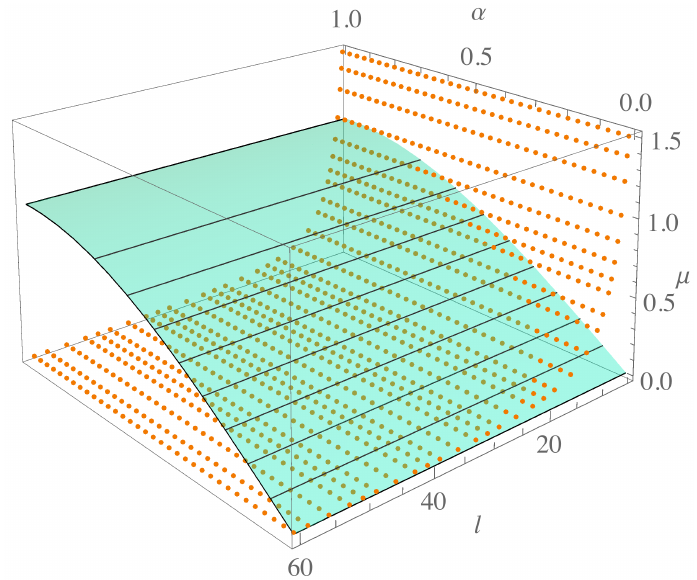
Figure 3. Intersection of the two surfaces µ c and µ α in the extended parameter space for 0 < α < 1.